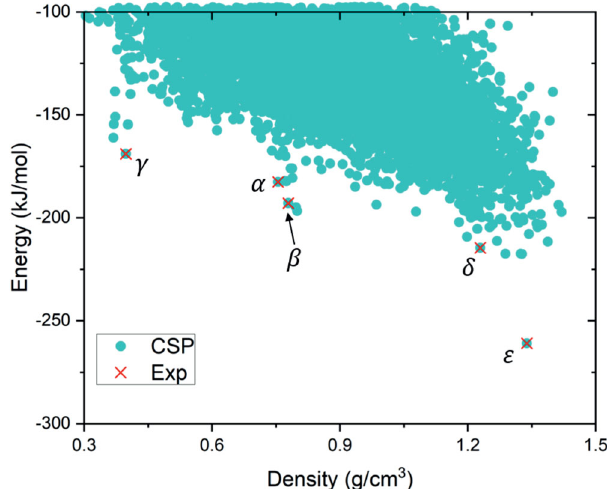
Fig. 7 Lattice energy vs density plot of the landscape of predicted crystal structures of TTBI. Lattice energy vs density plot of the landscape of predicted crystal structures of TTBI from CSP (quasi-random sampling), with predictions performed in P 1 with four molecules in the unit cell. The experimentally observed structures are labelled α , β , γ , δ and ε . The energy landscapes generated from threshold simulations are presented in Supplementary Figs. 6,